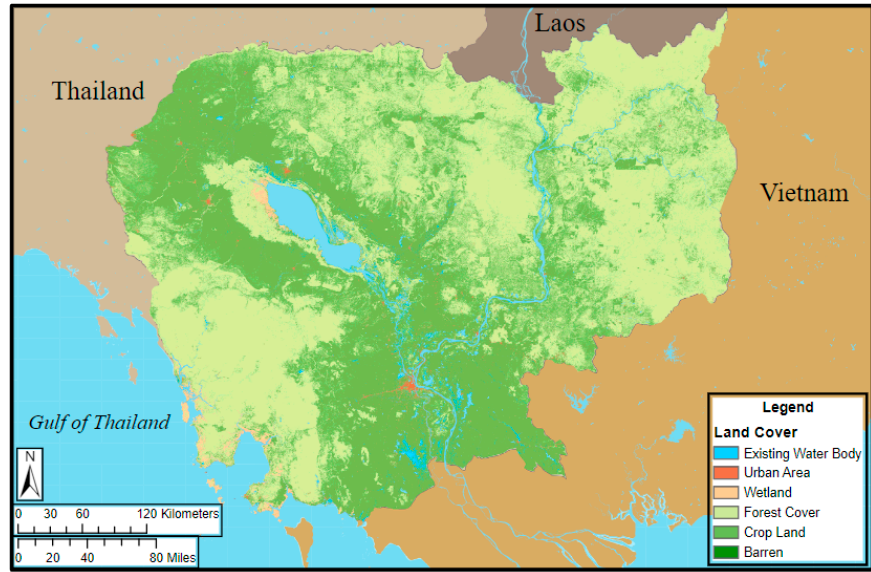
Figure 5. Land cover map of Cambodia. Adapted from ADPC’s [34] land use database.